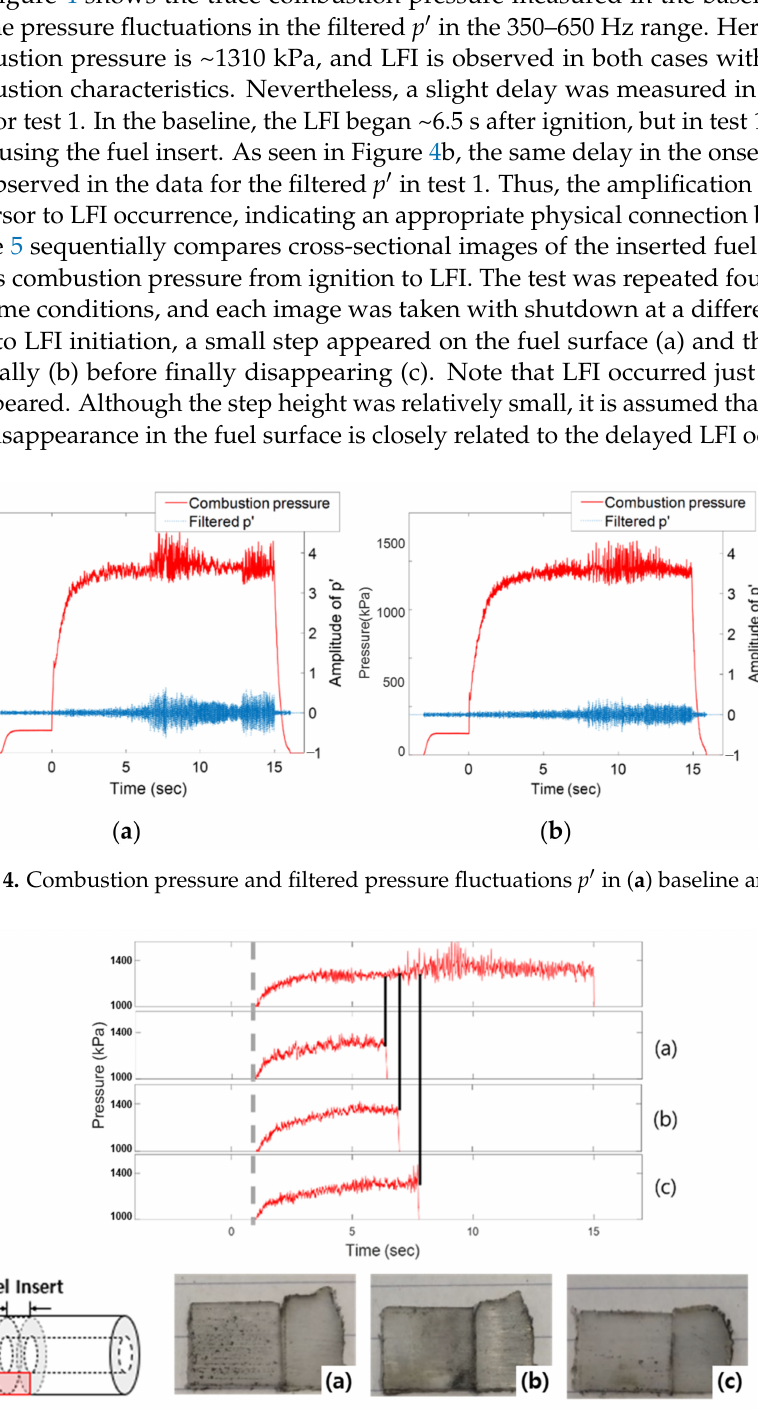
Figure 5. Sequential images of fuel cross section and corresponding pressure traces in test 1 up to ( a ) 6.4 s, ( b ) 7.6 s, and ( c ) 8.4